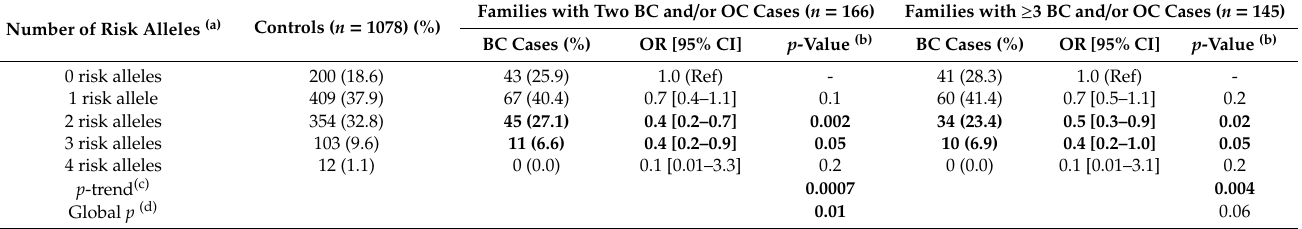
Table 4. Combined e ff ects of rs2242442 ( TBX3 ) and rs10497520 ( TTN ) on the risk of breast cancer according the number of BC cases in the